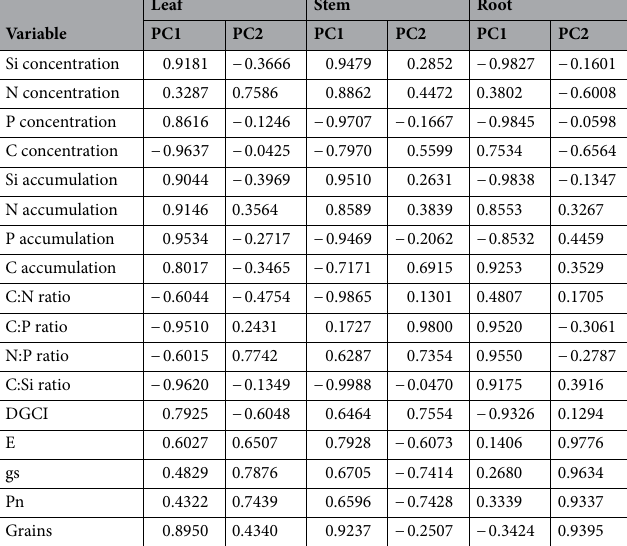
Table 1. Factor loadings extracted from independent variables in leaf (a), stem (b) and root (c) of grain sorghum plants under different Si